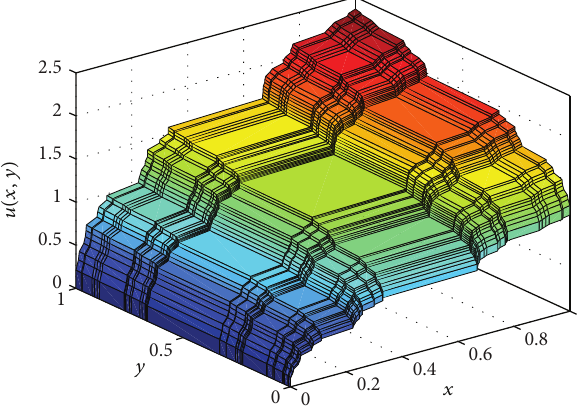
Figure 5: The plot of 𝑢 5 (𝑥,𝑦) with the parameter 𝛼 = ln 2/ ln 3 .